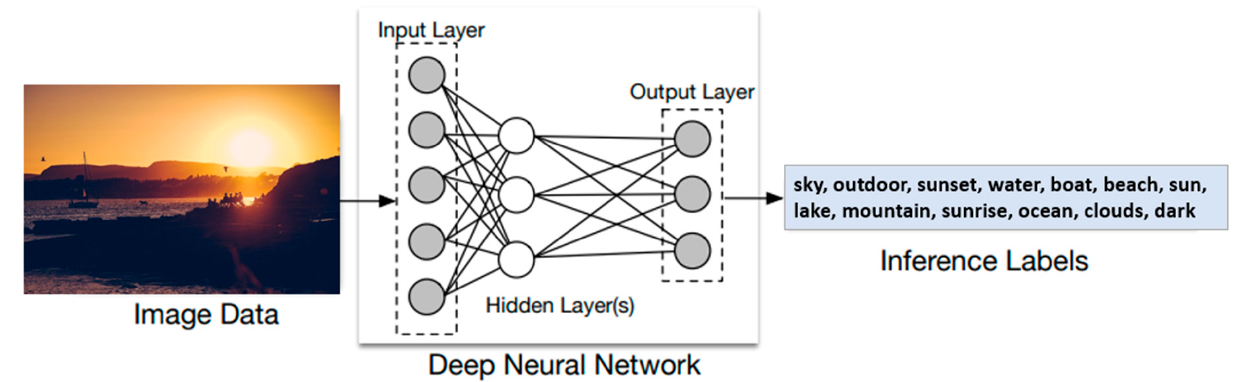
Figure 4. Object recognition of an image passing through a deep neural network (DNN).